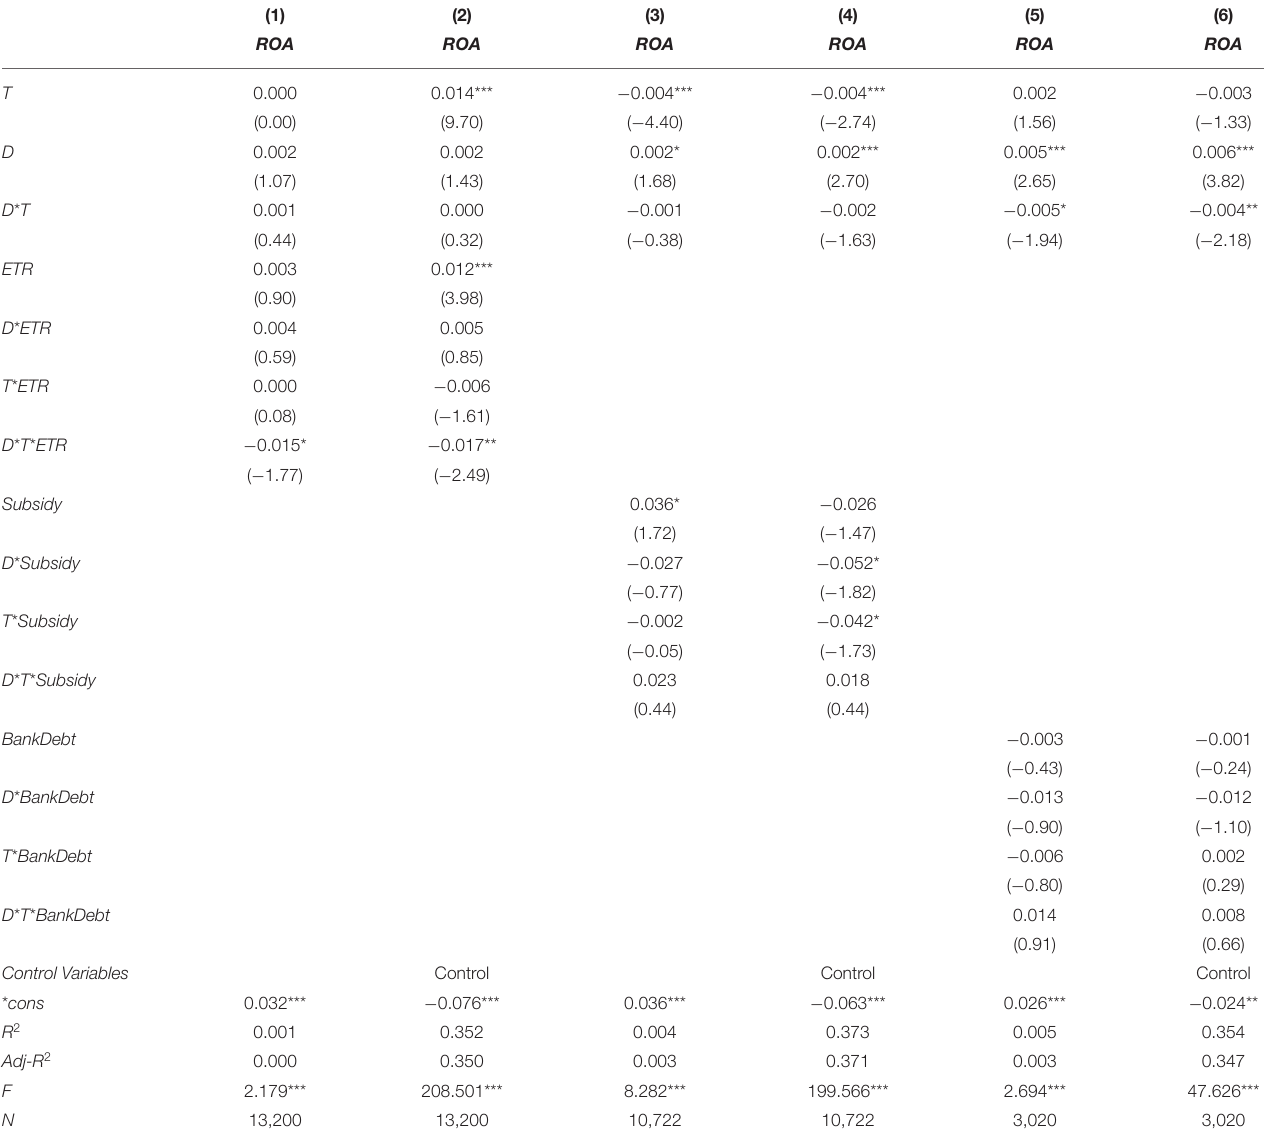
TABLE 7 | Regression analysis on the influence mechanisms of GID on firm